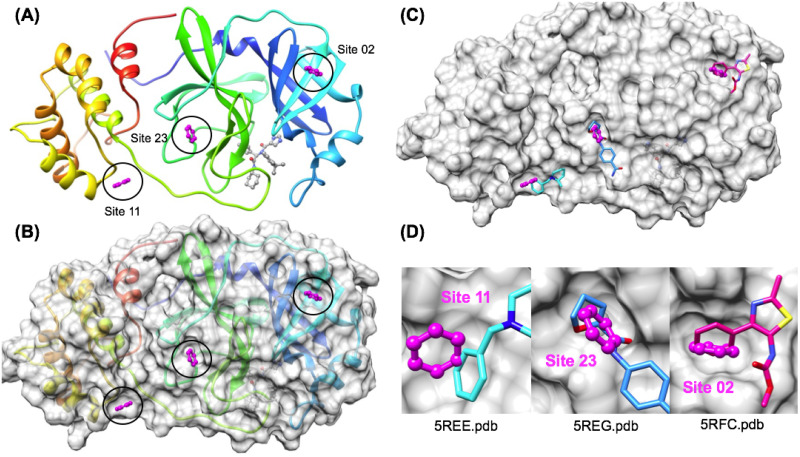
Experimental structures from fragment screening confirm other Nsp5 Mpro “minor” binding sites successfully predicted.The crystal structure of Nsp5 Mpro (6W63.pdb) is shown illustrating the reverse or “minor” binding surface using ribbon diagram with rainbow coloring (A) and is shown with a transparent gray surface in (B). Several crystal structures of other fragment ligands (5RFC.pdb, 5REE.pdb, 5REG.pdb) independently confirm the positions of the “minor” binding sites: Site 02, Site 11 and Site 23 pharmacophores shown in (C) and (D).